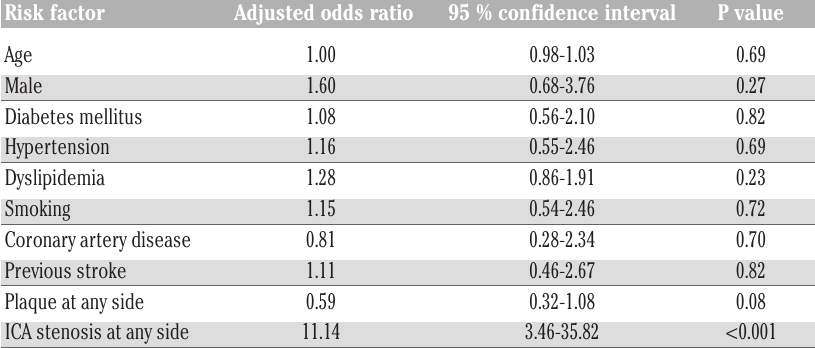
Table 3. Factors associated with large cerebral infarction by multivariate logistic regres- sion